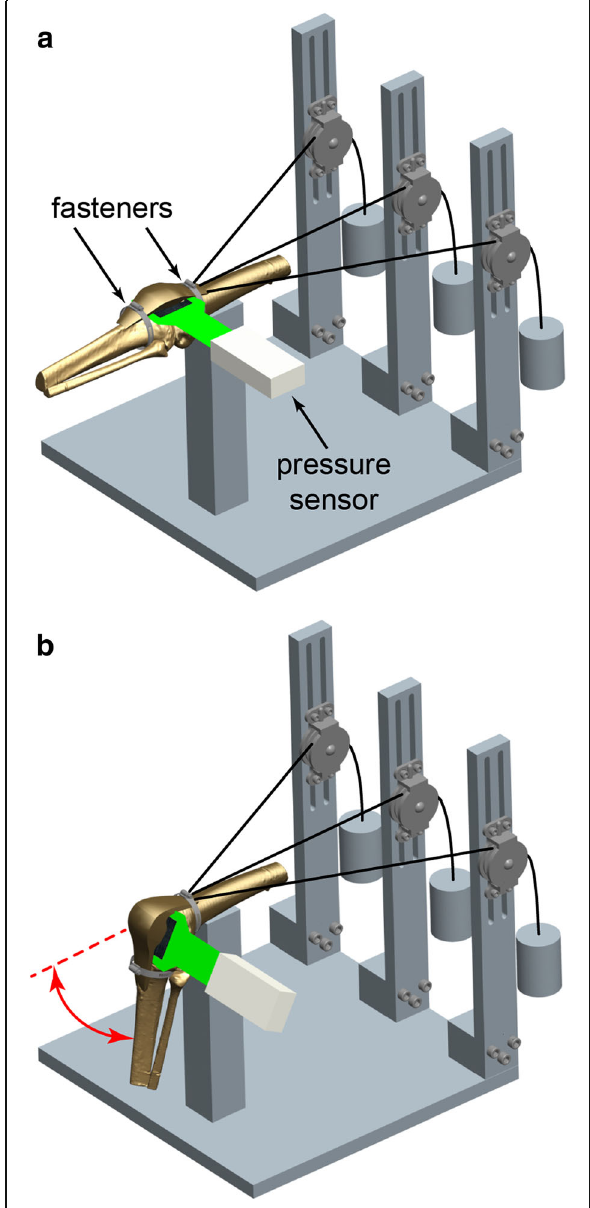
Fig. 2 Schematics of the testing setup. Patellofemoral contact force was measured with a thin-film pressure sensor in response to simulated anterior interval, suprapatellar pouch, and combined anterior interval and suprapatellar pouch adhesions (fasteners) at a 0° and b through a range of knee flexion angles spanning 0° –